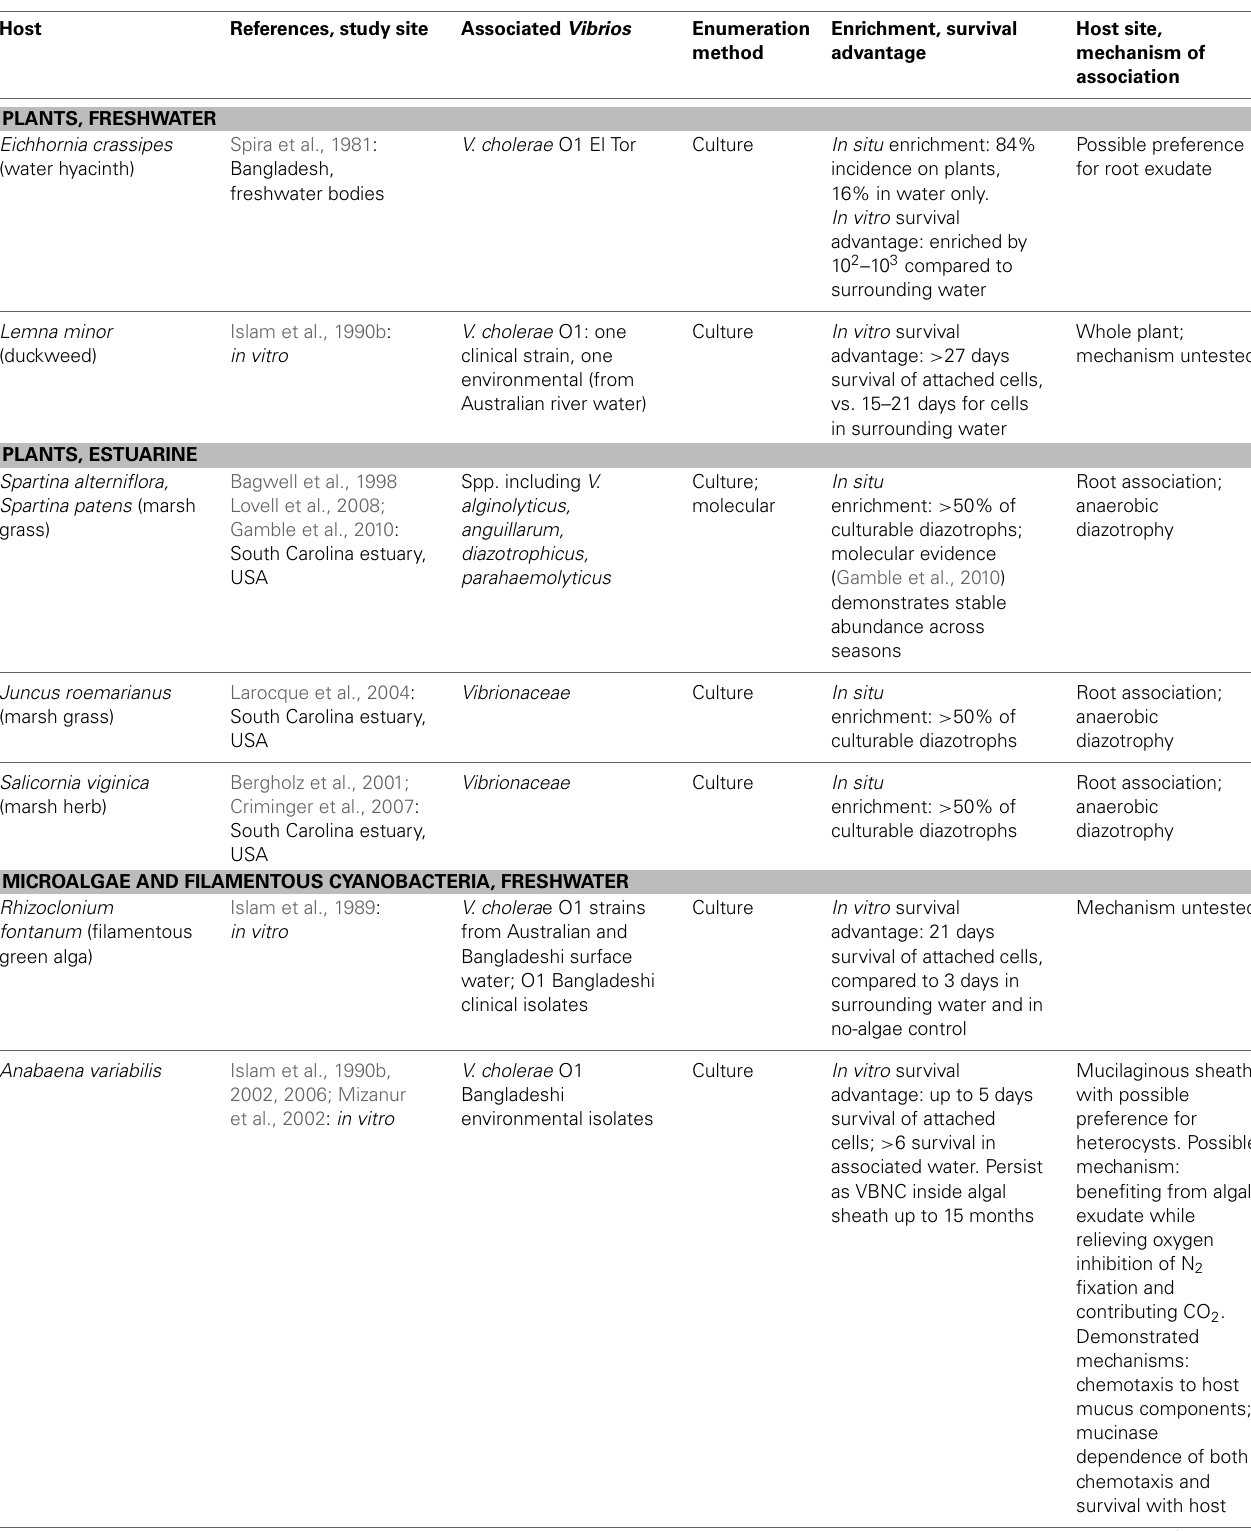
Table 1 | Plant and algae hosts for vibrio, as demonstrated by numerical enrichment and biological mechanisms supporting